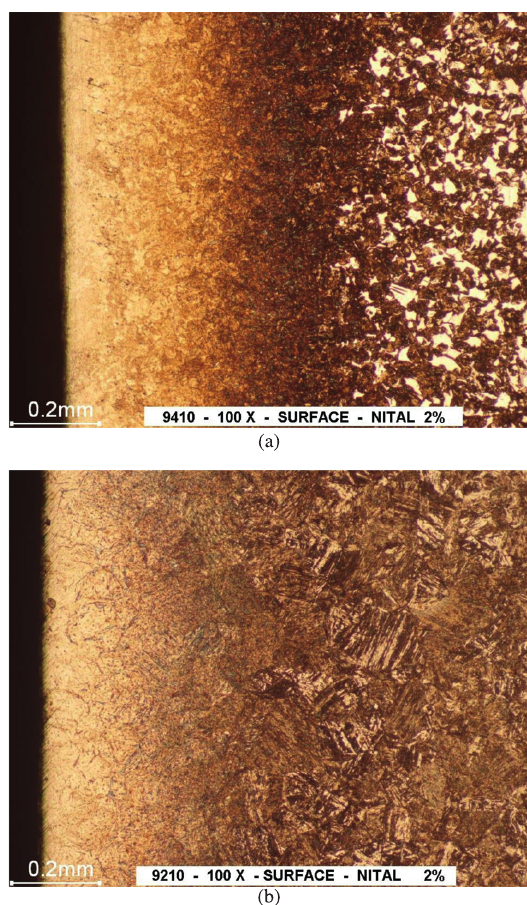
values for Figure 6. (Color online) Micrographs for two samples. Decarburized 1 regions are present at surface of both samples, but core hardness values are very different.